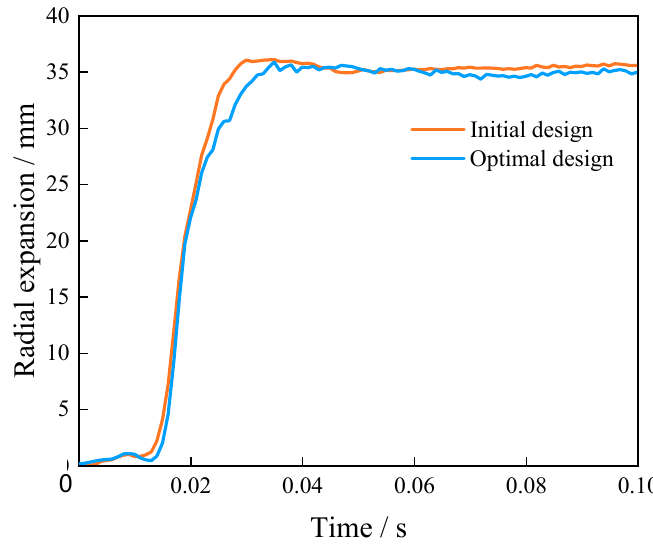
Figure 14. Radial expansion comparison.